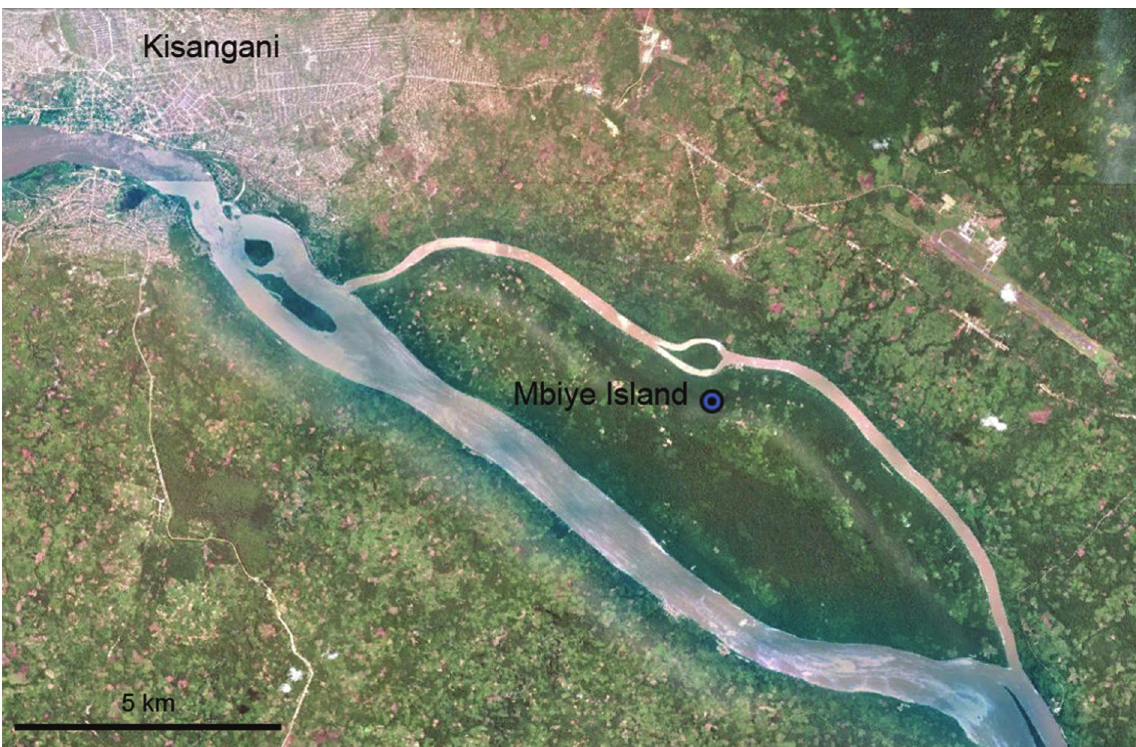
Fig. 1. Satellite image of the study area Mbiye Island, DRC (map data © 2012 Google & GeoEye). The blue point shows the collection locality of G. superba Hayman,